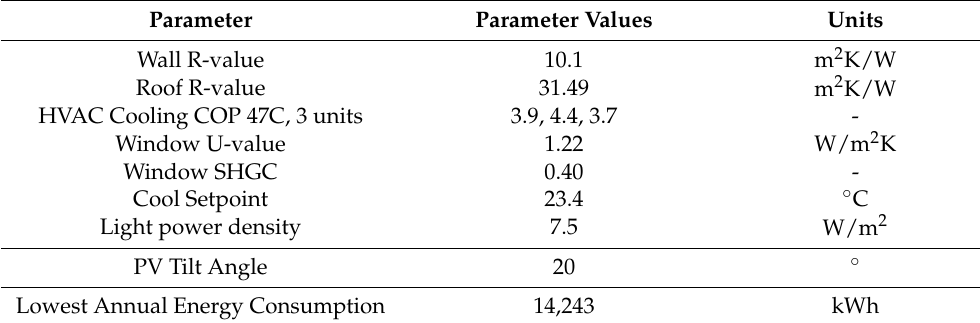
Table 1. Parameters used for the baseline model.